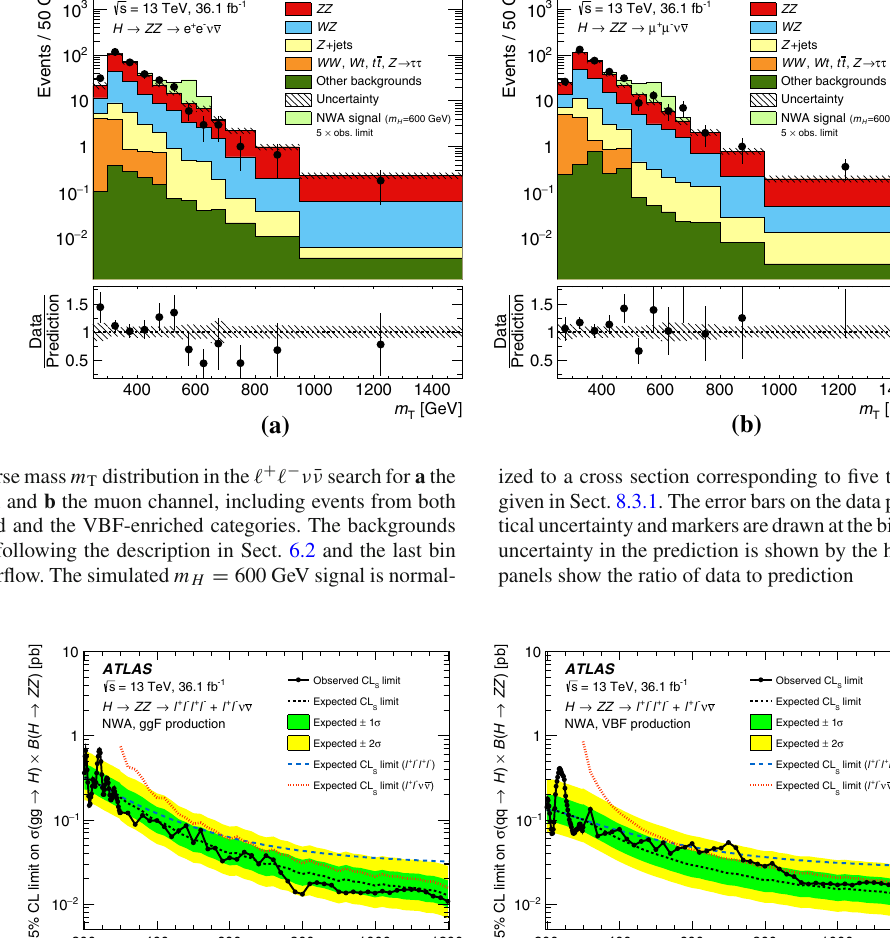
[GeV] H m yellow bands represent the ± 1 σ and ± 2 σ uncertainties in the expected limits. The dashed coloured lines indicate the expected limits obtained from the individual searches